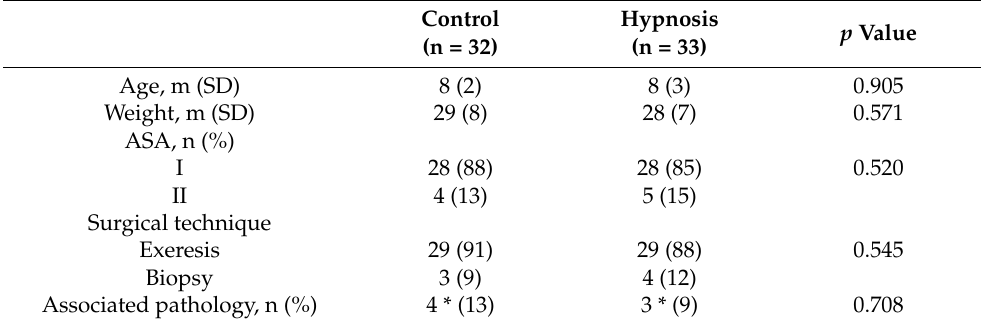
Table 1. Baseline characteristics of 65 children undergoing hypnosedation or distraction during major dermatological outpatient surgery.